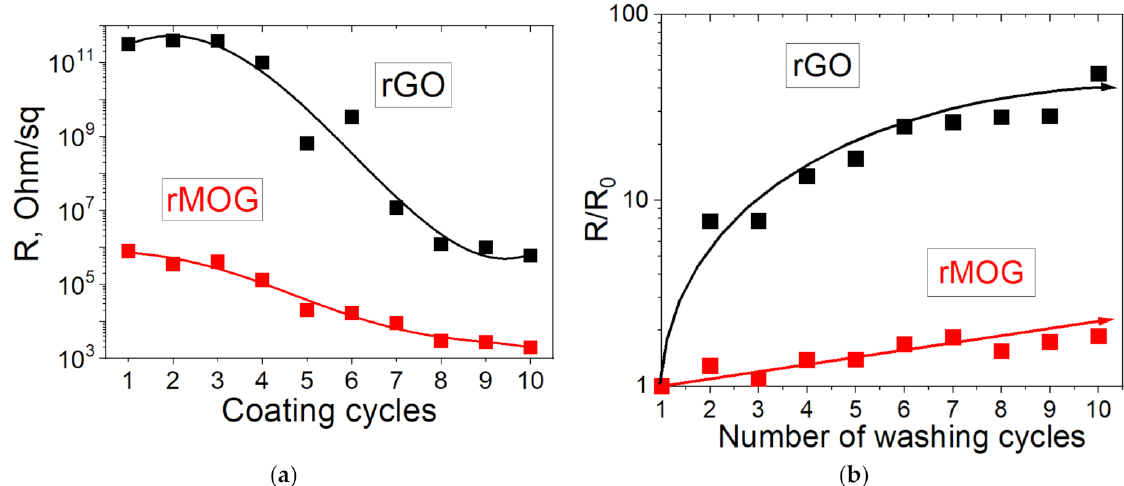
Figure 8. Change in the electrical resistance of fabrics with rGO and rMOG: ( a ) change from the coating cycles; ( b ) change from the number of washing cycles.